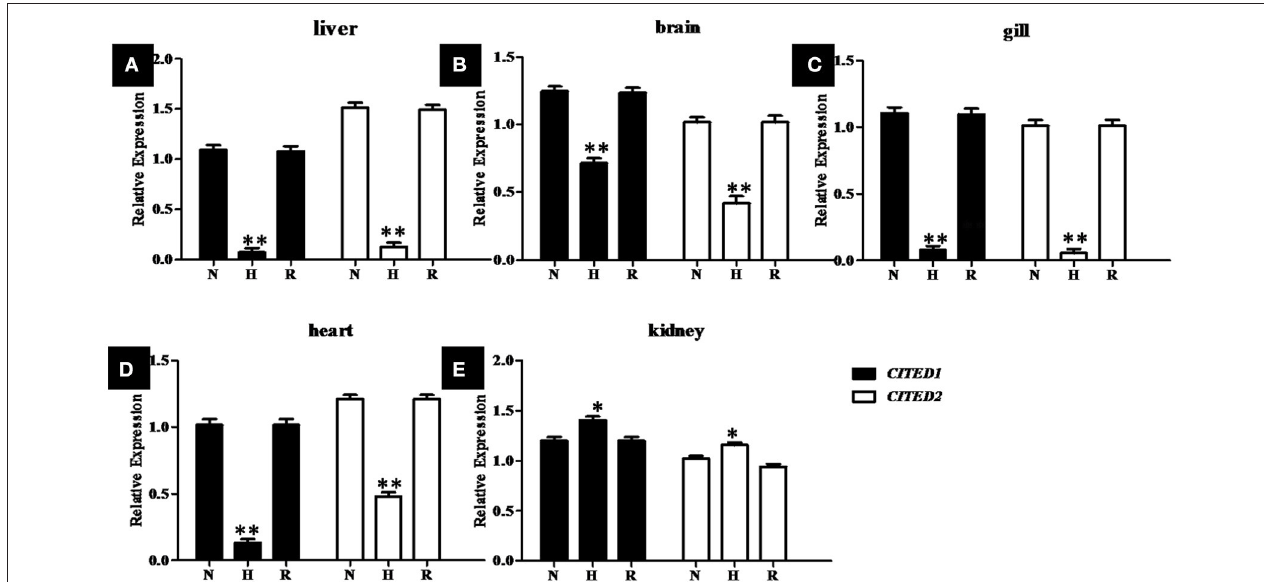
FIGURE 7 | Relative levels of CITED1 and -2 transcripts in liver (A) , brain (B) , gill (C) , heart (D) , and kidney (E) during normoxic (N), hypoxic (H) and recovery (R) conditions of blunt snout bream. H: 4h hypoxia (DO = 1.0 ± 0.5mg/L) treatment; R, 24h normoxic recovery (DO = 7.0 ± 0.5 mg/L); N, DO = 7.0 ± 0.5mg/L. The CITED1 / − 2 copy numbers were normalized to the amount of 18S mRNA. qRT-PCR data presented as mean ± SE (n = 5); * p < 0.01; ** p < 0.001.